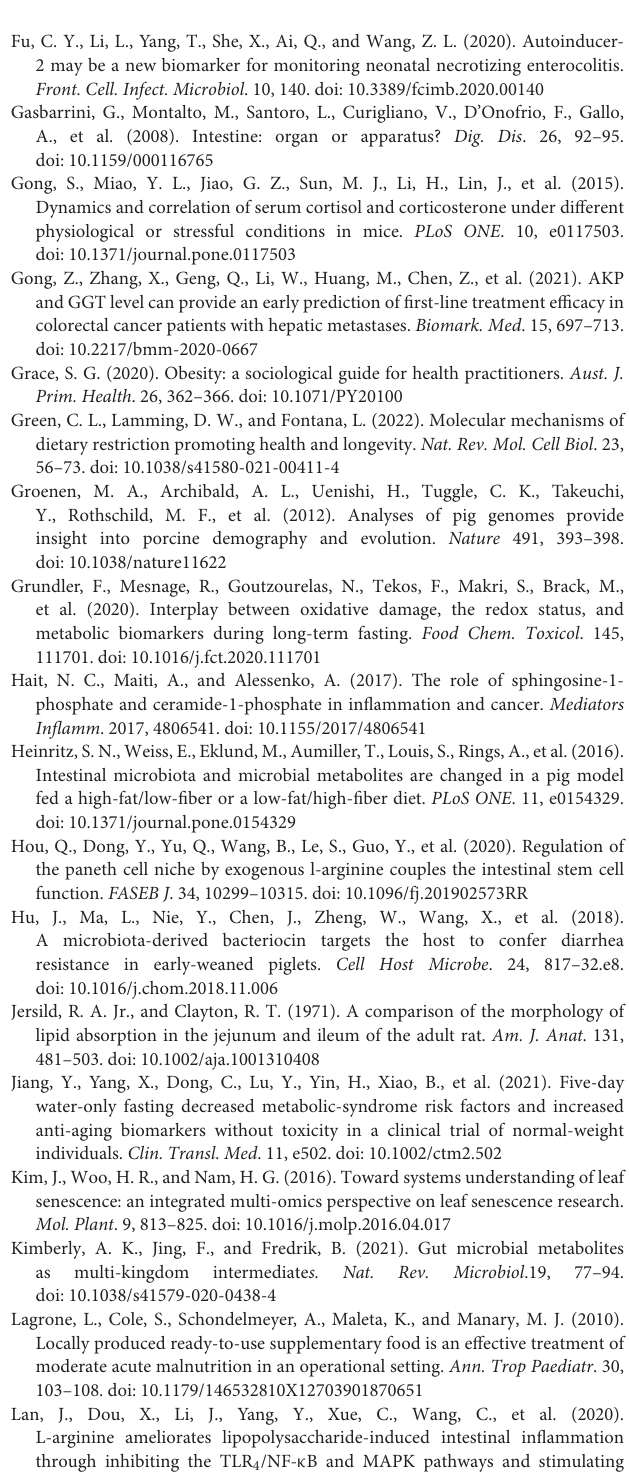
Supplementary Table S10 | Coordinate results of response variables based on the CCA analysis. Supplementary Table S11 | Metabolites detected in the positive-ion mode.